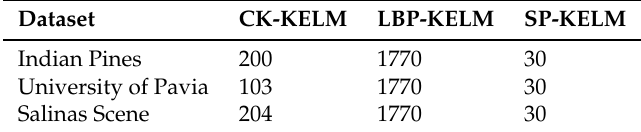
Table 6. Dimension of spatial features learned by the spectral-spatial approaches on HSI datasets. Dataset